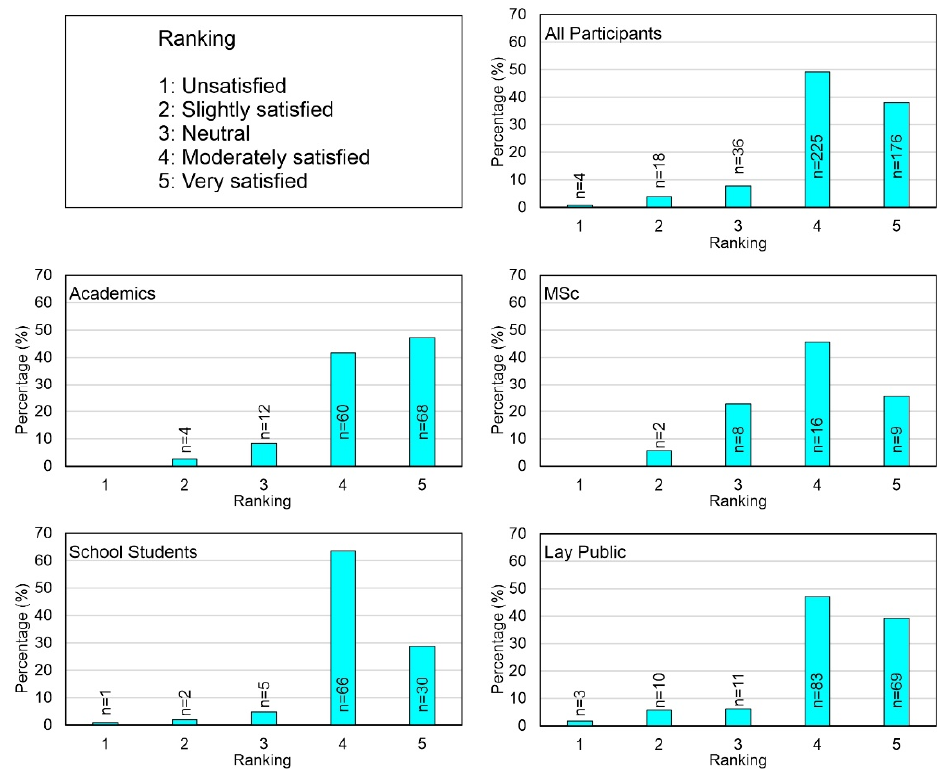
Figure 10. Bar charts showing the portrayal feedback of the Immersive Virtual Reality exploration. The results represent both the total number of participants and the background of each group respectively.